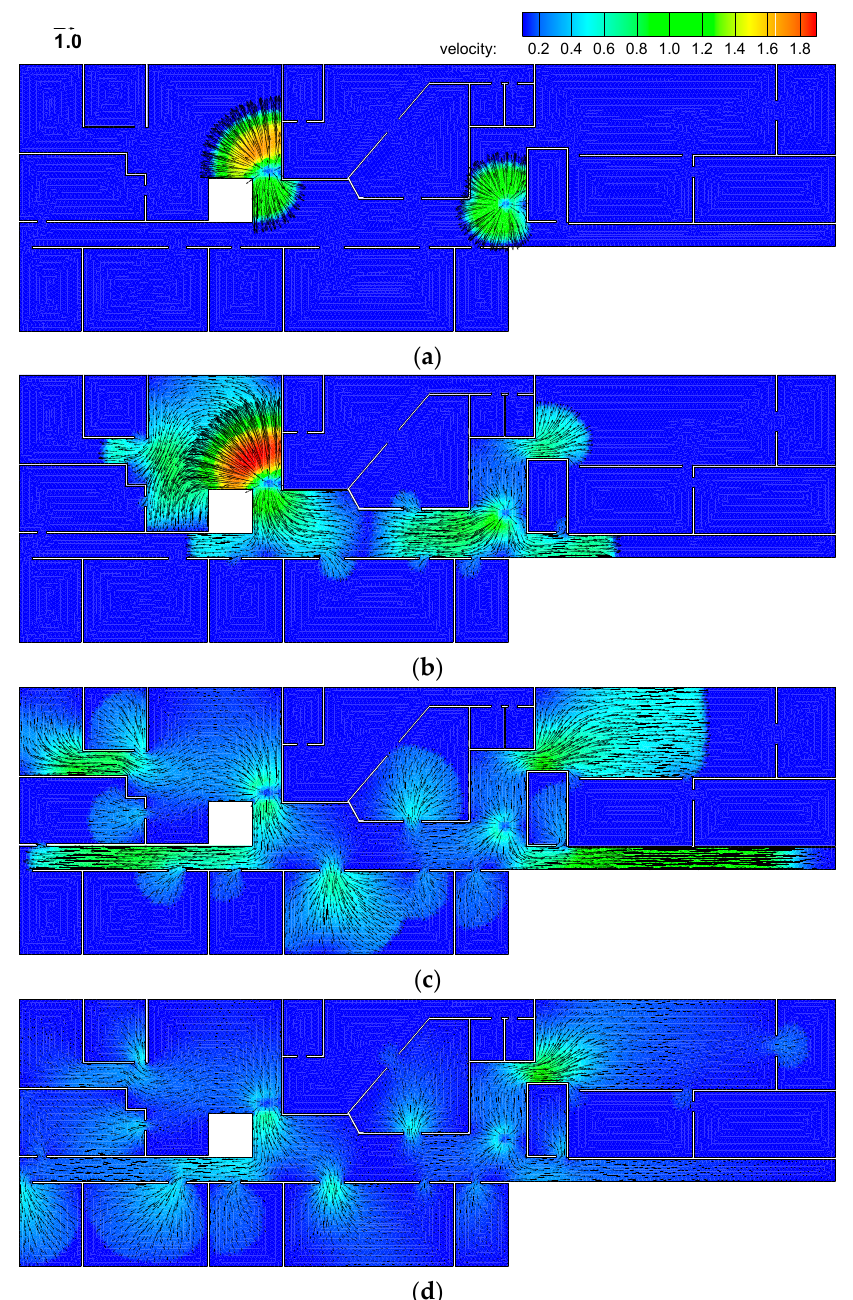
Figure 10. Velocities in the underground space (unit of contour legend: m/s); ( a ) t = 15 s; ( b ) t = 30 s; ( c ) t = 60 s; ( d ) t = 100 s.